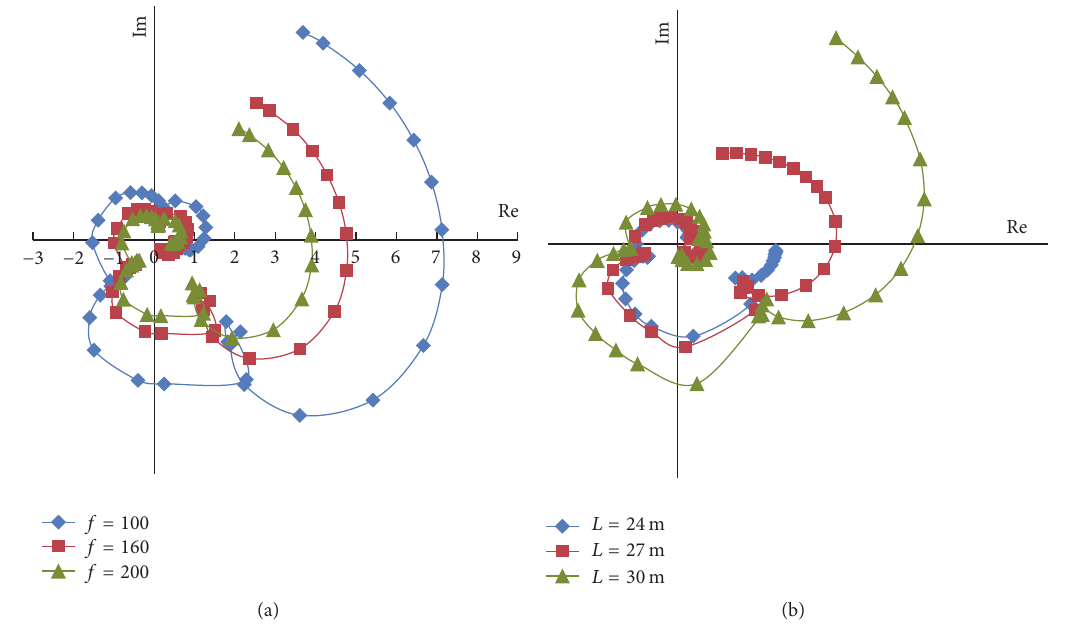
Figure 4: Nyquist curves of the system. (a) Different inlet throttling coefficient. (b) Different heated